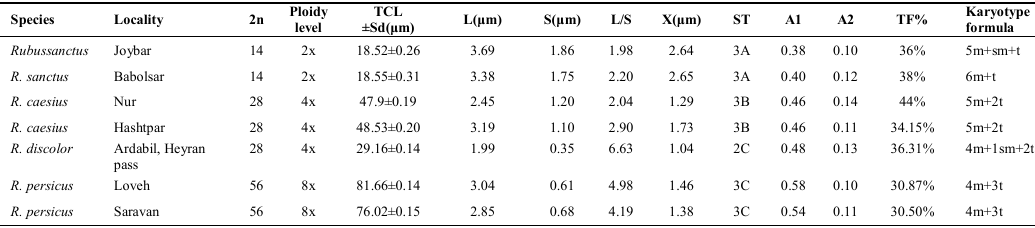
Table 2. Karyotypic details of Rubus species or populations* Species Locality 2n Karyotype formula